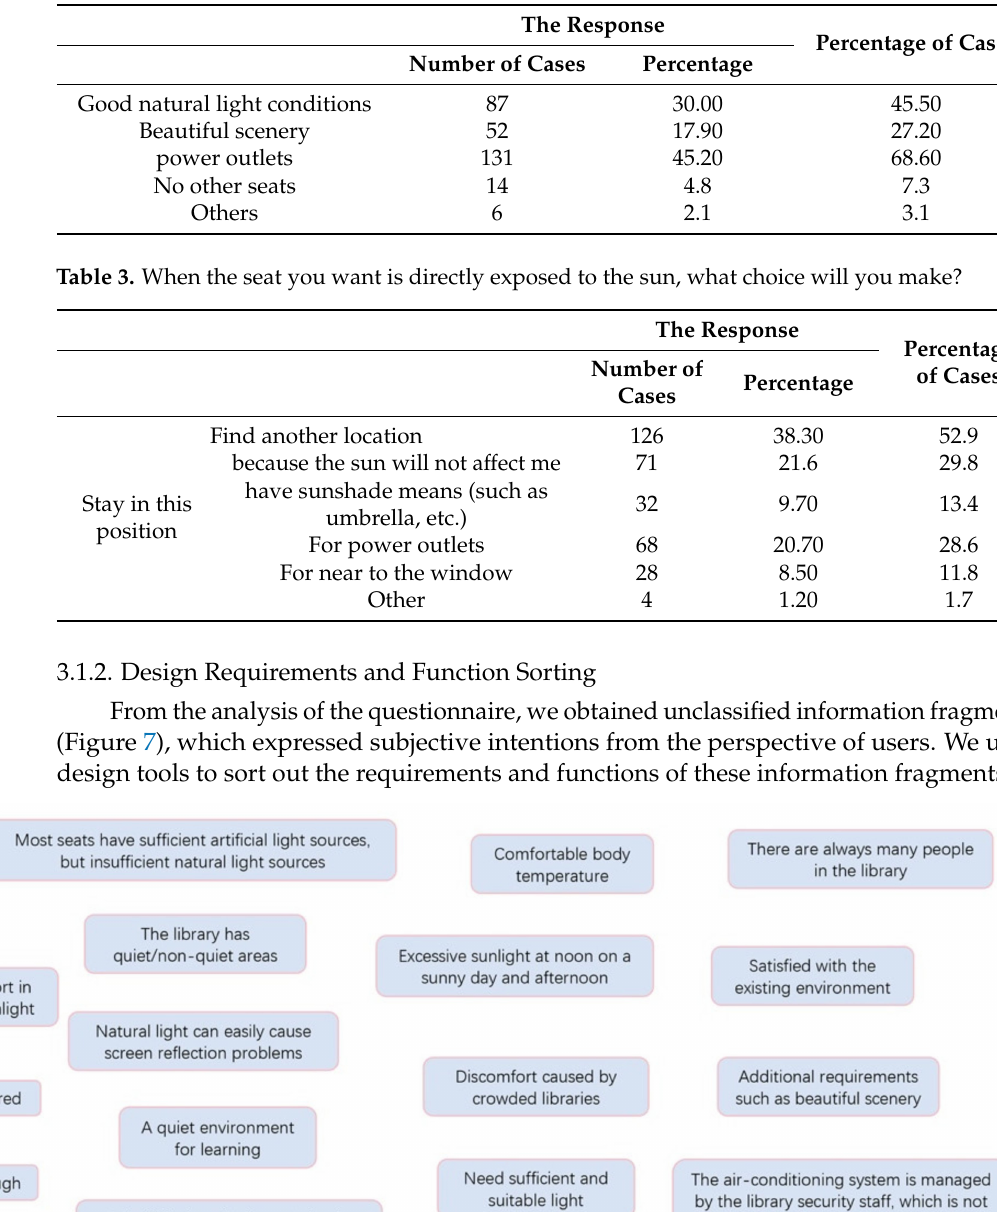
Table 2. Why you choose a window seat.